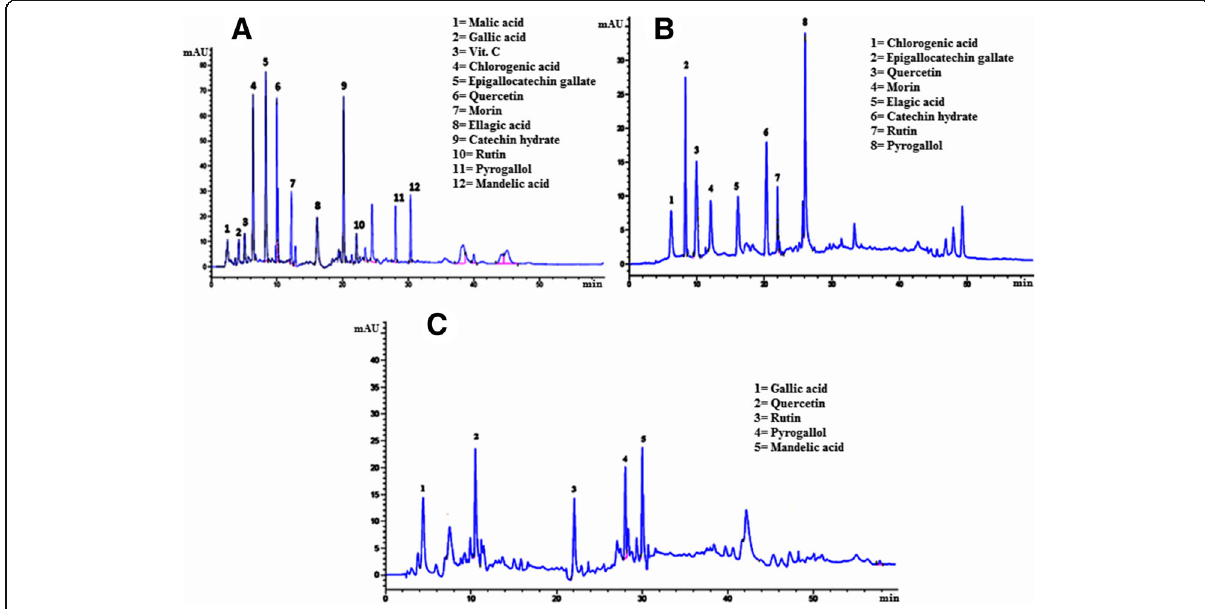
Fig. 2 HPLC-UV Chromatograms of phenolic compounds in E. umbellata Thunb. fruit a Me.Ext, b Chf-Ext and c